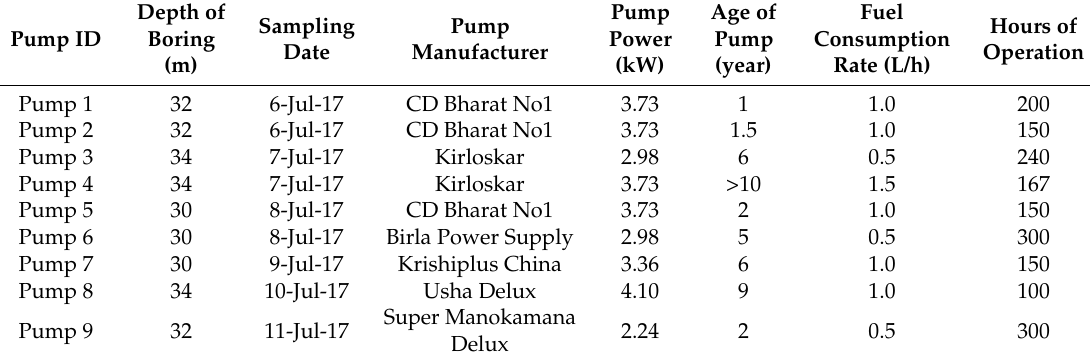
Table 1. Characteristics of diesel irrigation pumps measured during our